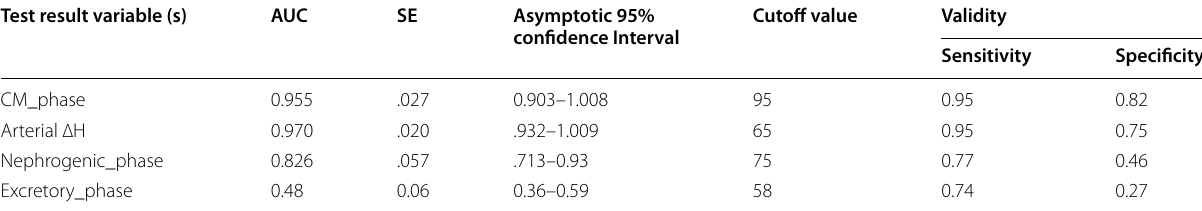
Table 6 Cutoff value differentiation between CRCC/CHRCC from other types Test result variable